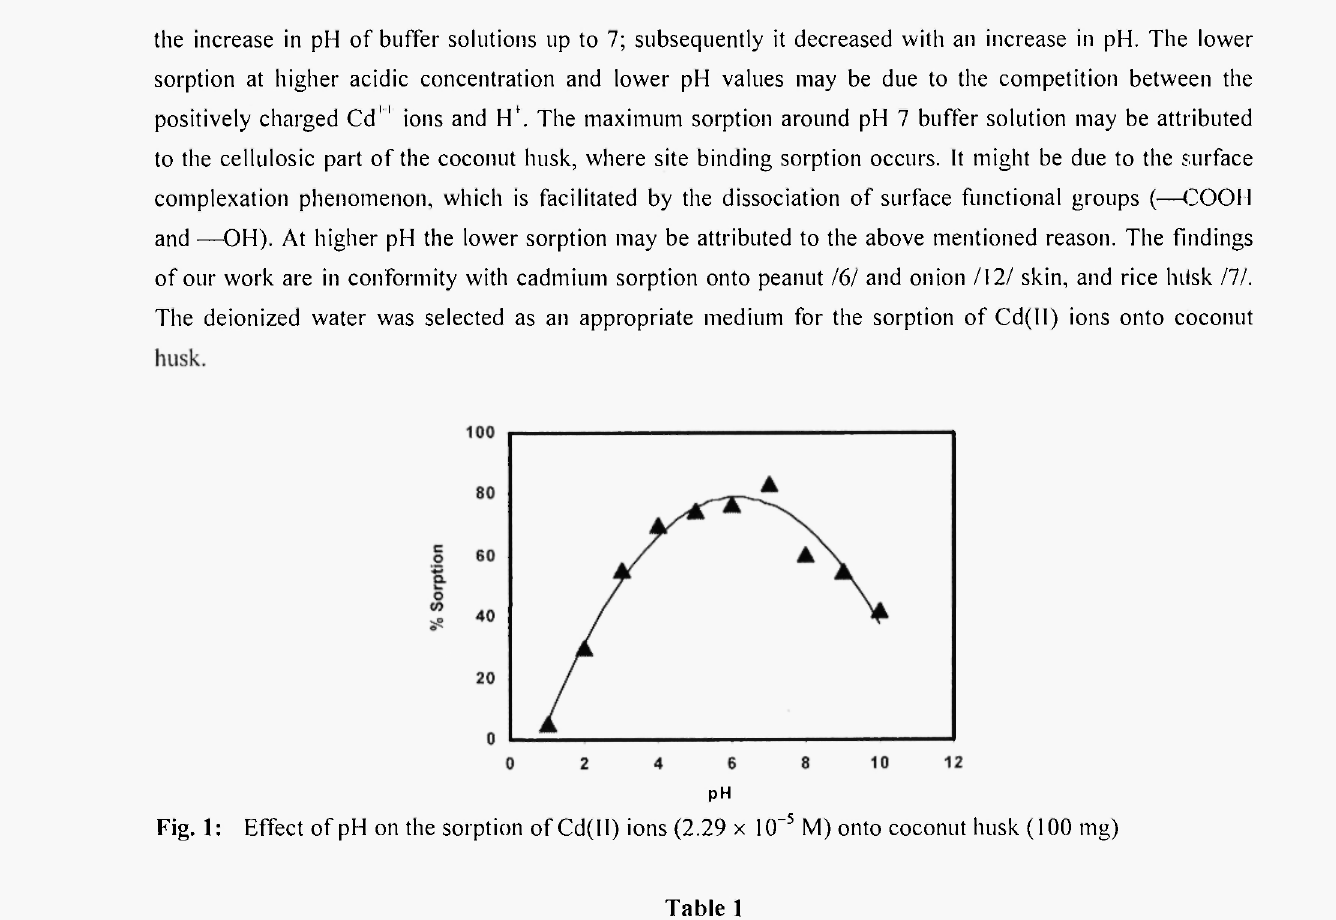
Fig. 1: Effect of pH on the sorption of Cd(II) ions (2.29 χ 10" 5 M) onto coconut husk (100